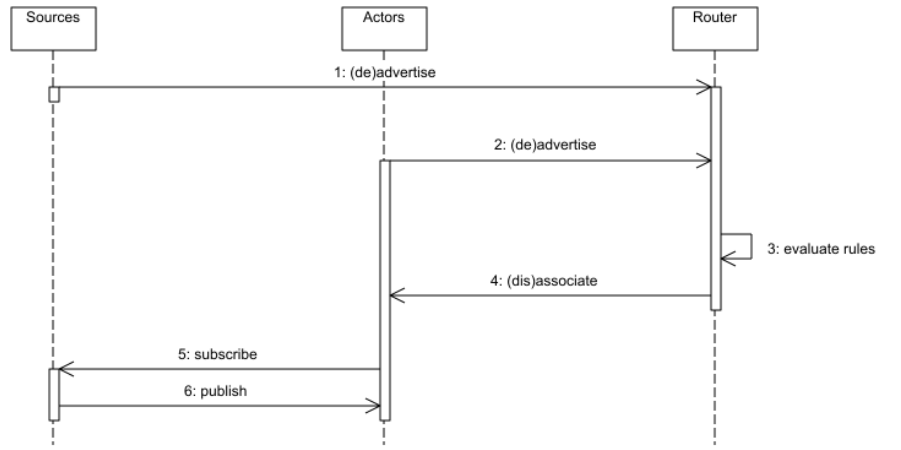
Figure 8. Coaty: Interactions of Sensors and Actors with the